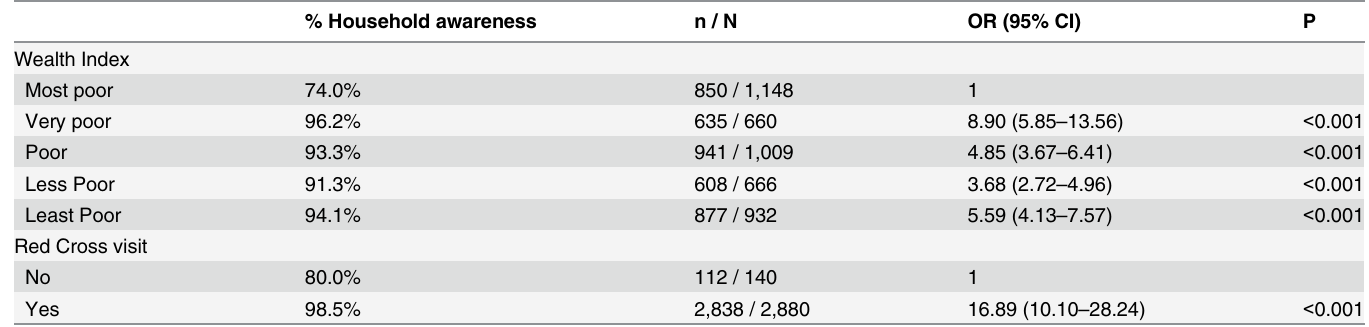
Table 3. Univariable associations of household awareness of polio campaigns with socio-economic index and Red Cross household visit. % Household awareness n / N OR (95% CI)